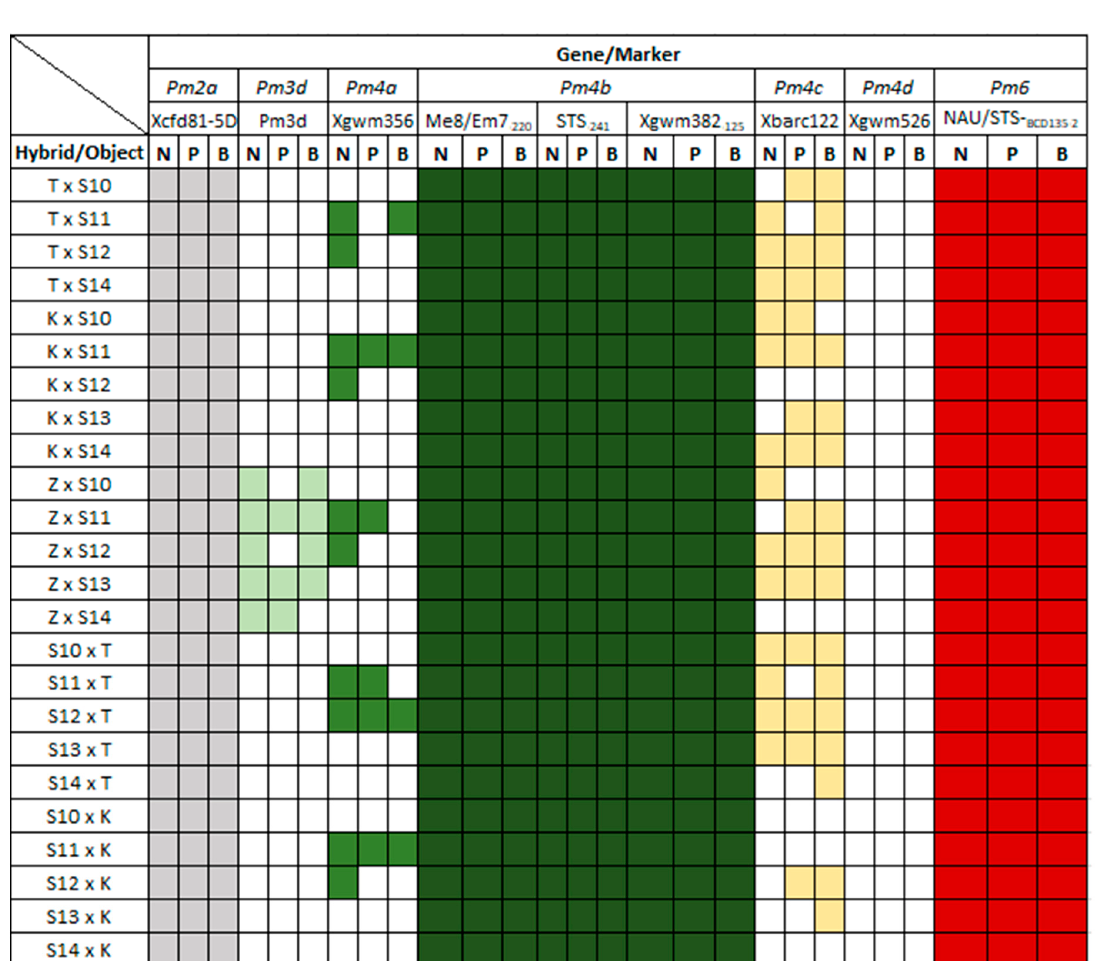
Figure 5. Identification of gene markers associated with wheat resistance to B. graminis f. sp. tritici in bread wheat cultivars and five spelt lines as the parental forms of bread wheat-spelt breeding lines.